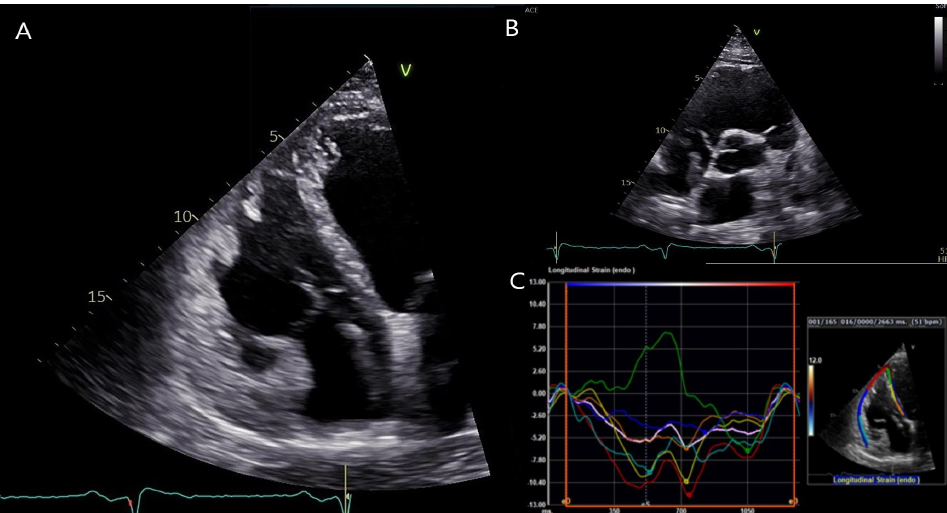
Figure 4. Transthoracic echocardiography of the patient. ( A ): Apical four-chamber view showing a dilated right ventricle (RV). ( B ): Parasternal short axis view showing RV outflow tract dilation. ( C ): RV free wall strain was significantly impaired ( − 7.7%). Segmental strain showed more impaired values for the septal, inferior and apical segments in both left ventricular and right ventricular segments, and mostly showing post-systolic shortening phenomenon. Usually, the septum is spared by the disease process in classical right dominant ARVC. Conversely, as illustrated by the green segmental strain curve, the RV apicoseptal region was dyskinetic in our patient with DSP cardiomyopathy.